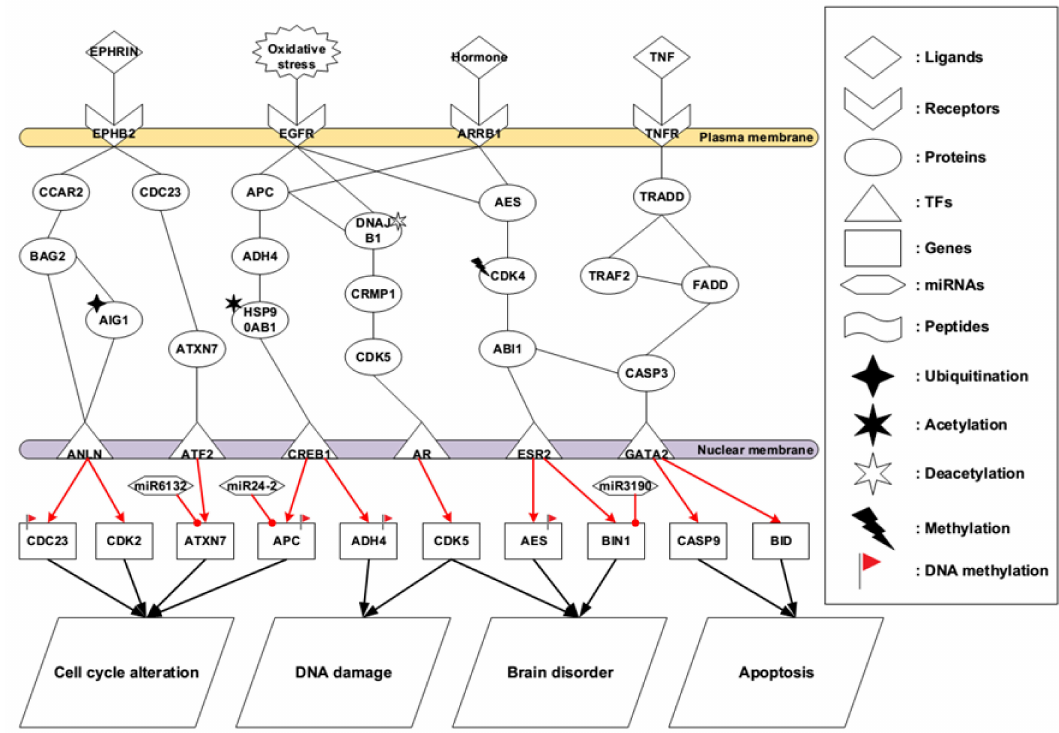
Figure 4. The core pathways in later stage AD. The core members were extracted from the core GENs in Figure 2B, showing the molecular mechanism to regulate the later events in AD. With the deterioration of the disease, the later stage AD brain is heavily influenced by multiple impacts including cell cycle alteration, DNA damage, brain disorder, and apoptosis. The black lines indicate the protein–protein interaction; the red lines with arrowhead denote the regulation from upstream to downstream; the final cellular functions are mediated by target genes. Notations of genetic and epigenetic regulations are listed at the right